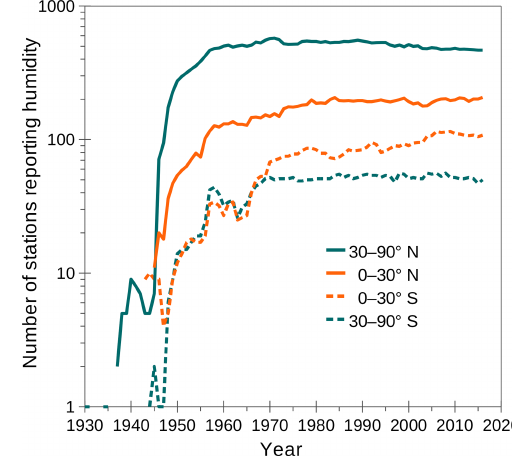
Figure 4. Yearly number of IGRA-RS fixed stations reporting hu- midity in northern and southern tropical and extratropical latitudes, since the time of the earliest radiosonde humidity